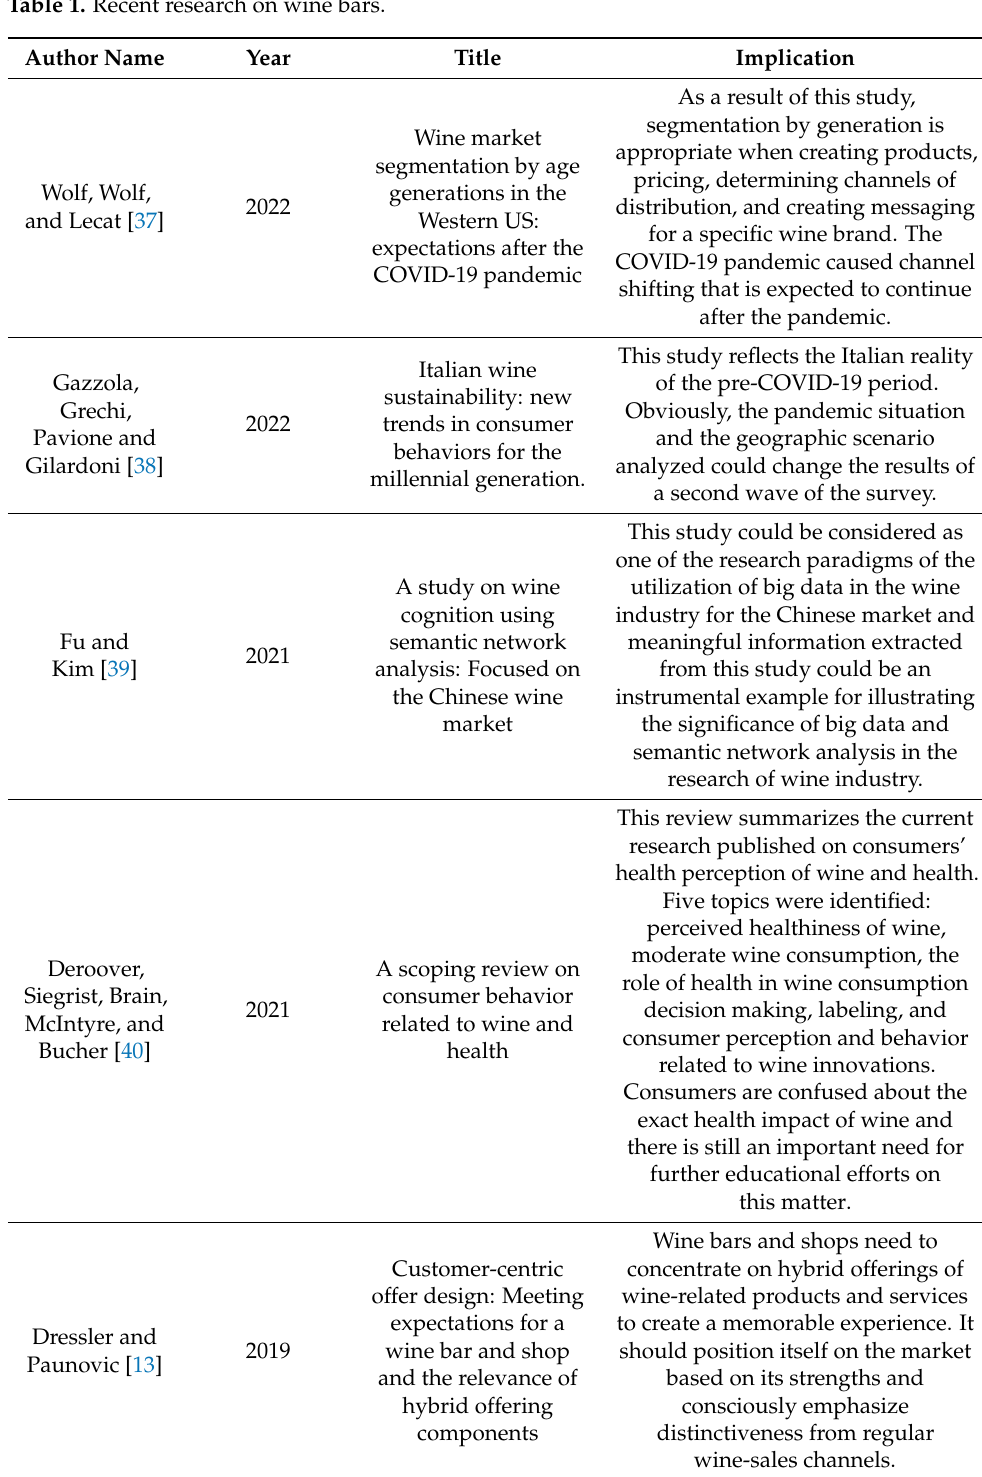
Table 1. Recent research on wine